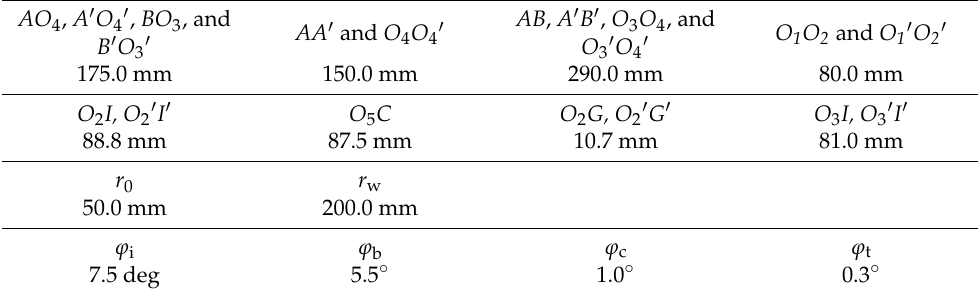
Table 1. The parameters of the parallel mechanism.